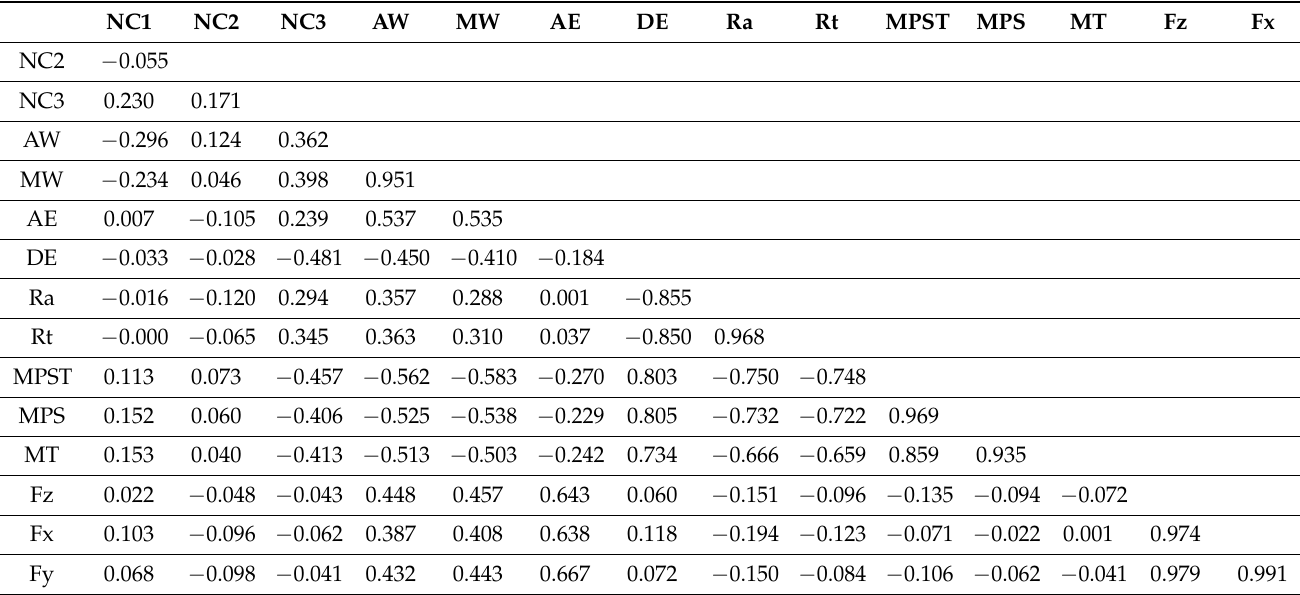
Table 5. Pearson correlation for all response